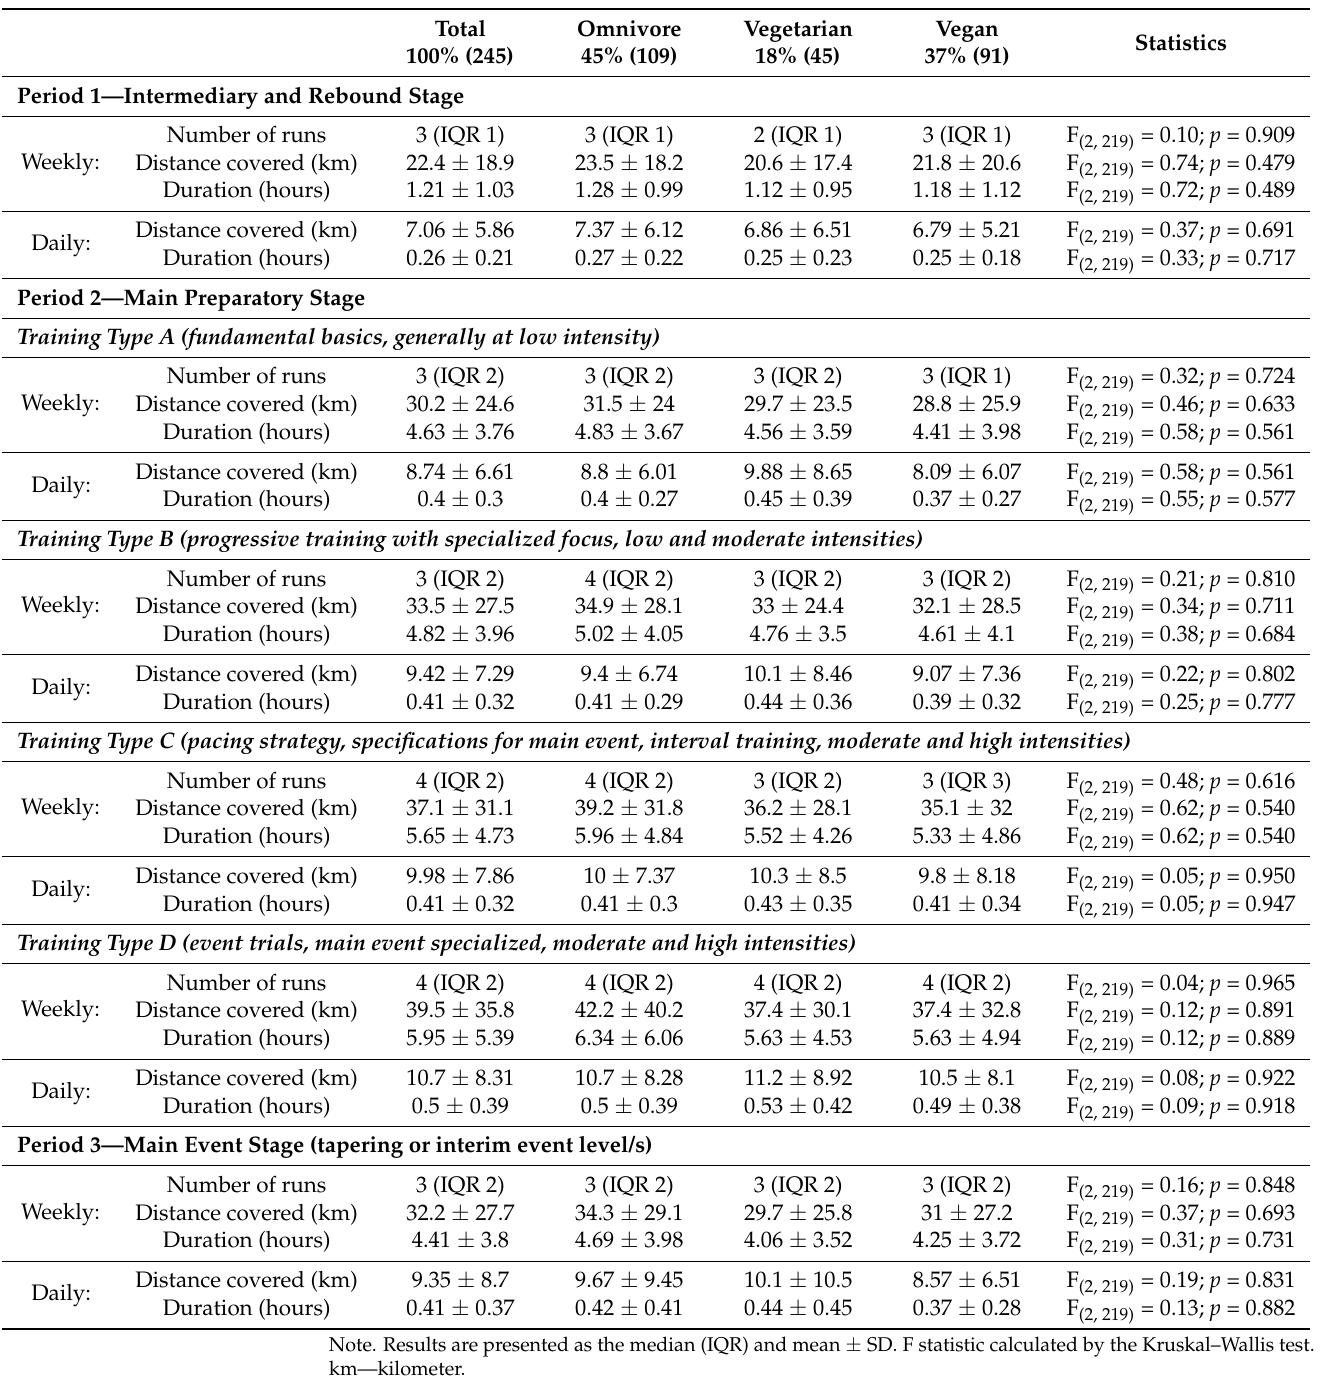
Table 3. Periodization Outline of Runners, Including Specified Training Types Presented by